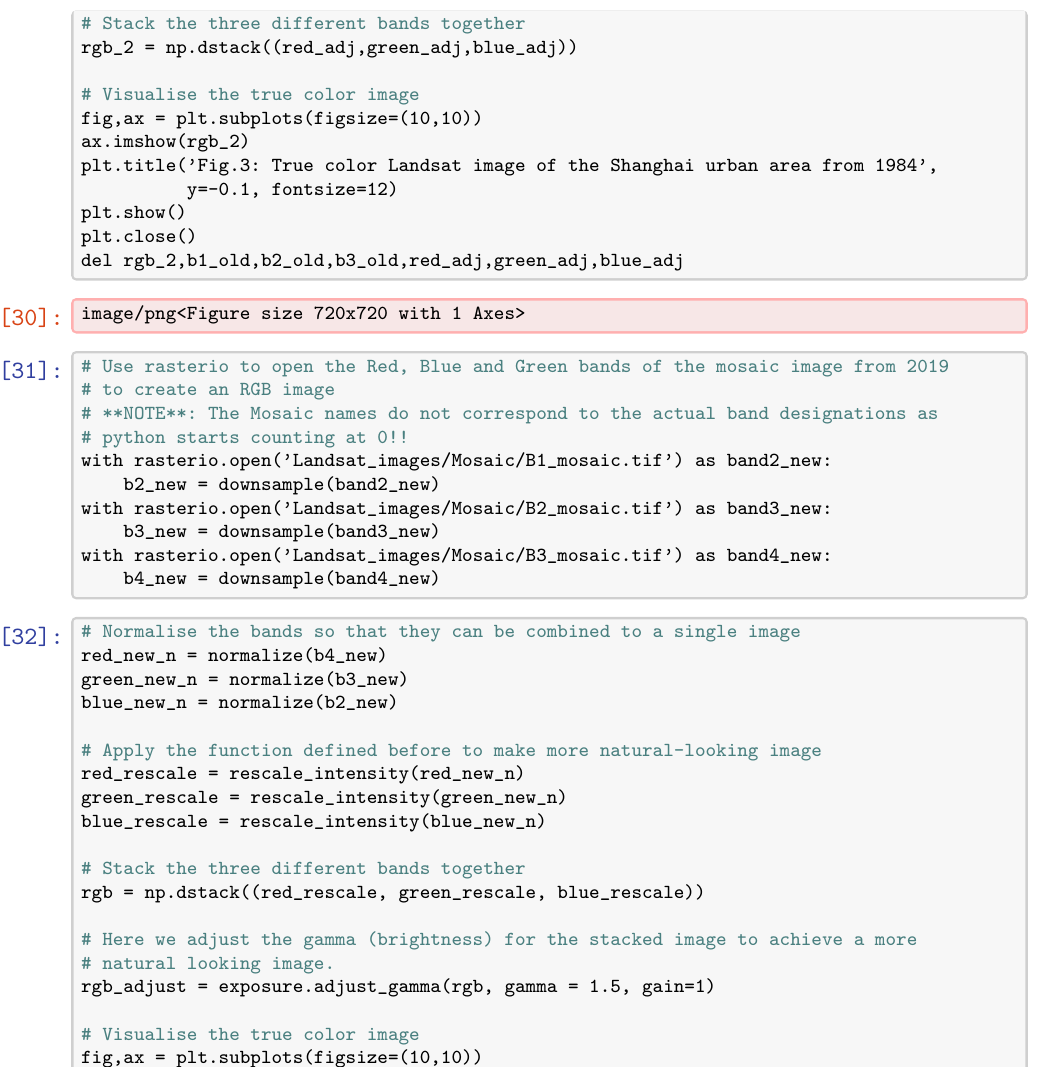
Figure 3: True colour Landsat image of the Shanghai urban area from 1984